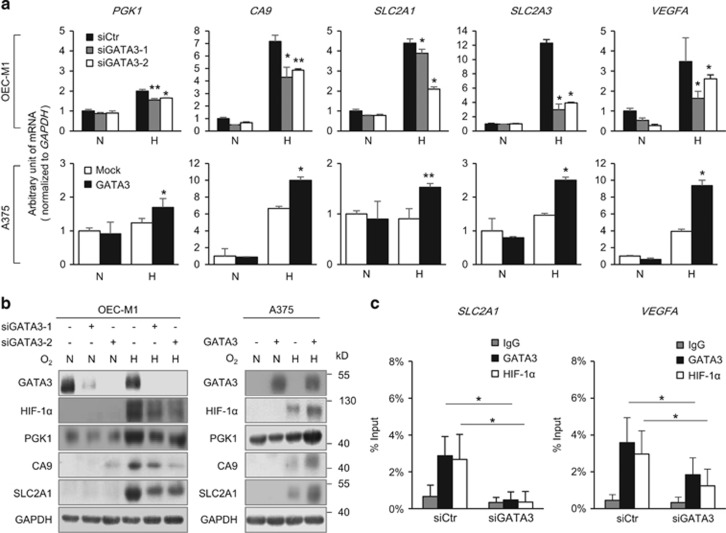
GATA3 regulates expression of HIF-1 target genes under hypoxic conditions. (a) Real-time RT-PCR analysis of the expression of HIF-1α target genes, including PGK1, CA9, SLC2A1, SLC2A3 and VEGFA in OEC-M1 and A375 cells. (b) Western blot analysis of GATA3, HIF-1α, PGK1, CA9 and SLC2A1. GAPDH was an internal control. Total RNAs and cell lysates were extracted from cells grown under normoxia (N) or hypoxia (H), as indicated. (c) ChIP assays with anti-GATA3 or anti-HIF-1α antibody and SLC2A1 and VEGFA genes in OEC-M1 cells. Control or GATA3 knockdown cells were cultured under hypoxia for overnight and then harvested for ChIP assays. Isotype matched IgG was used as controls. The results are represented as mean±s.d. from three independent experiments. *P<0.05, **P<0.01.